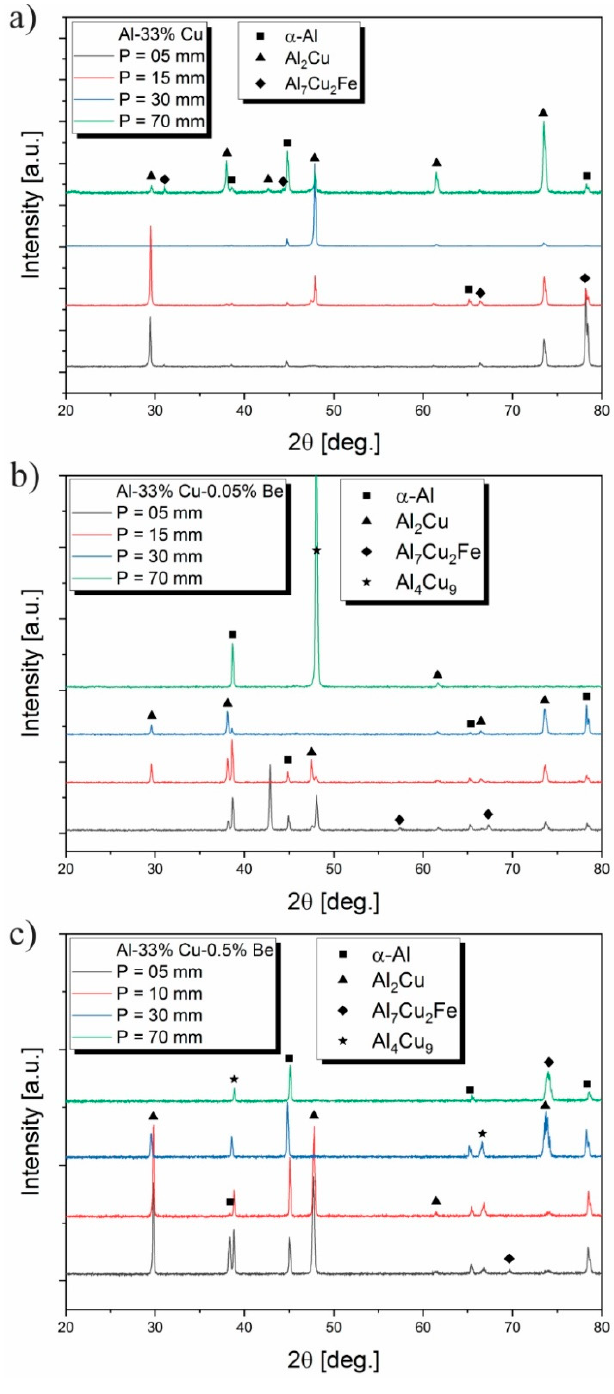
Figure 9. XRD patterns at four different positions (P), chosen by similarity of Ṫ values, in the ( a ) Al-33 wt.%Cu, ( b ) Al-33 wt.%Cu-0.05 wt.%Be and ( c ) Al-33 wt.%Cu-0.5 wt.%Be alloys.